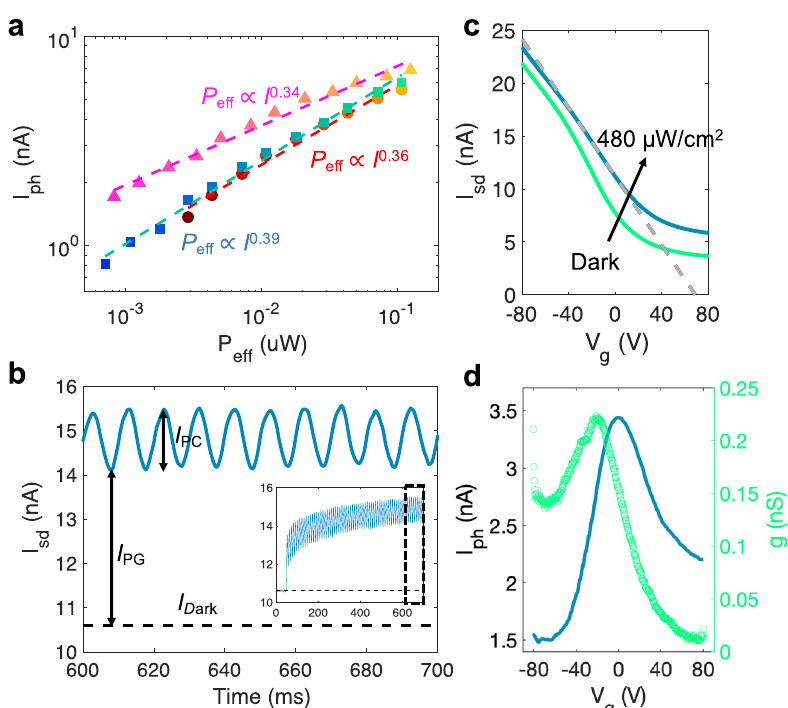
Fig. 4 Power and gate dependence of photocurrent. a Photocurrent versus effective incident power for excitation energies of 1.98 eV (color gradient in red tone), 2.33 eV (color gradient in green tone), and 3.22 eV (color gradient in magenta tone). The dashed lines are obtained from . b Drain current as a function of time under illumination modulated at a a linear fi t to each data set by following the power-law I ph ∝ P α eff frequency of 10 Hz and excitation energy of 2.33 eV and a power density of 480 µW/cm 2 . The horizontal dashed line indicates the amount of drain current in the dark. The inset shows the same drain current on a longer time scale, with a black dashed rectangle indicating the main plot zone. Measurements in ( a , b ) have been performed at V sd = 5 V and V g = 0 V for device C ( ∼ 40 nm thick). c Transfer curves under dark and illumination (2.33 eV) conditions at V sd = 5 V. The dashed black line is a linear fi t to the dark transfer curve, obtaining a V T = 36.9 V. The calculated shift in threshold voltage when illuminating ( Δ V T = 32.1 V) is indicated by a dashed gray line. d Device photocurrent (blue line) and transconductance (green dots) obtained from the plot in panel ( c ). Results in ( c , d ) have been performed for device D ( ∼ 40 nm